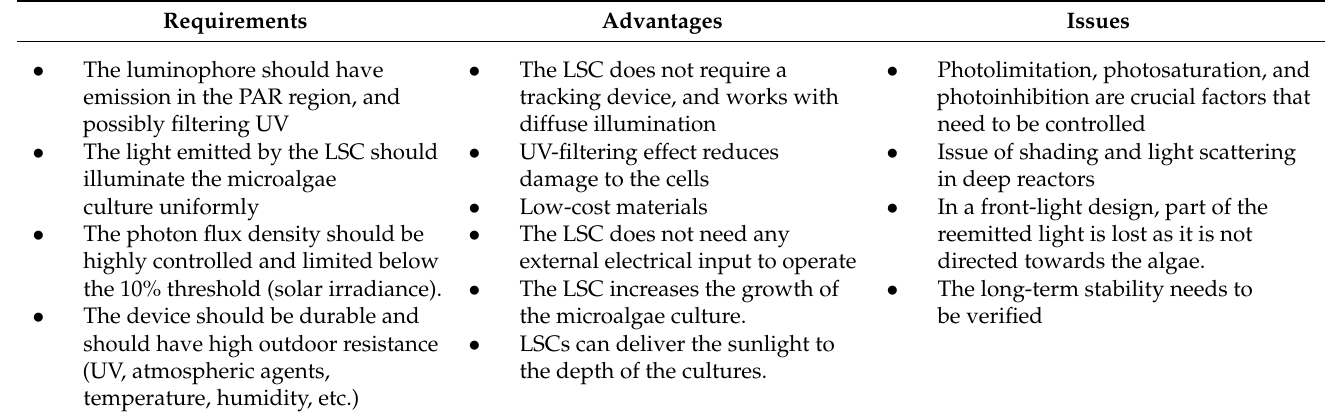
Table 4. Summary of the key parameters of LSC devices for microalgal